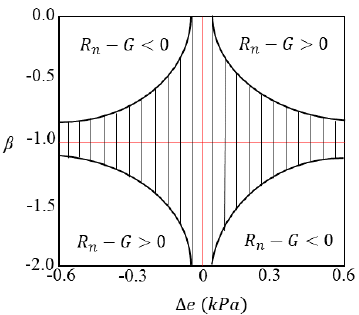
Figure 6. Rejection domain dynamic graph .